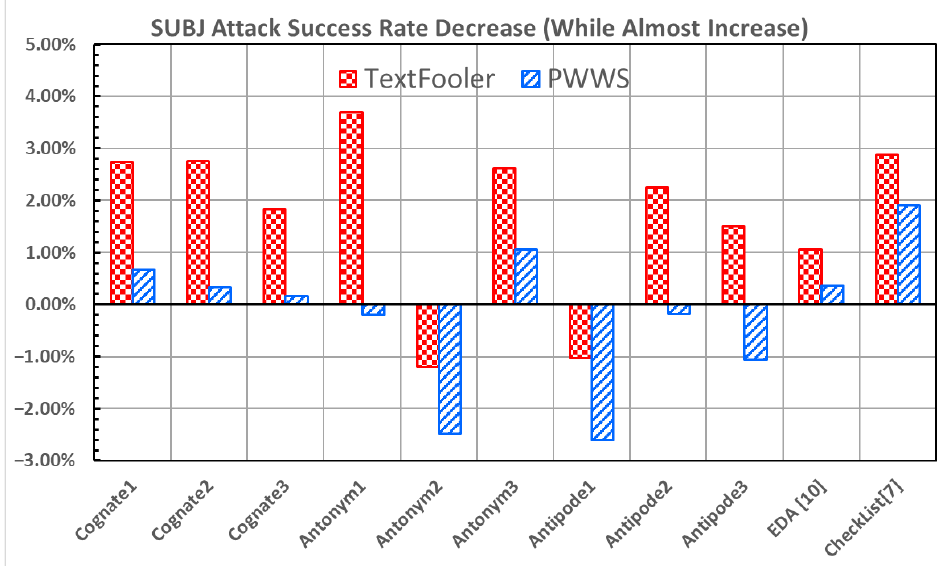
Figure 10. SUBJ Attack Success Rate Decrease.